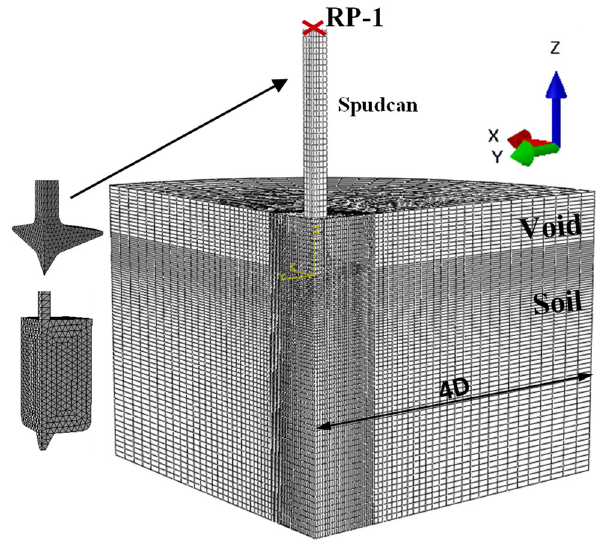
Figure 2. FE model of soil and the spudcan.